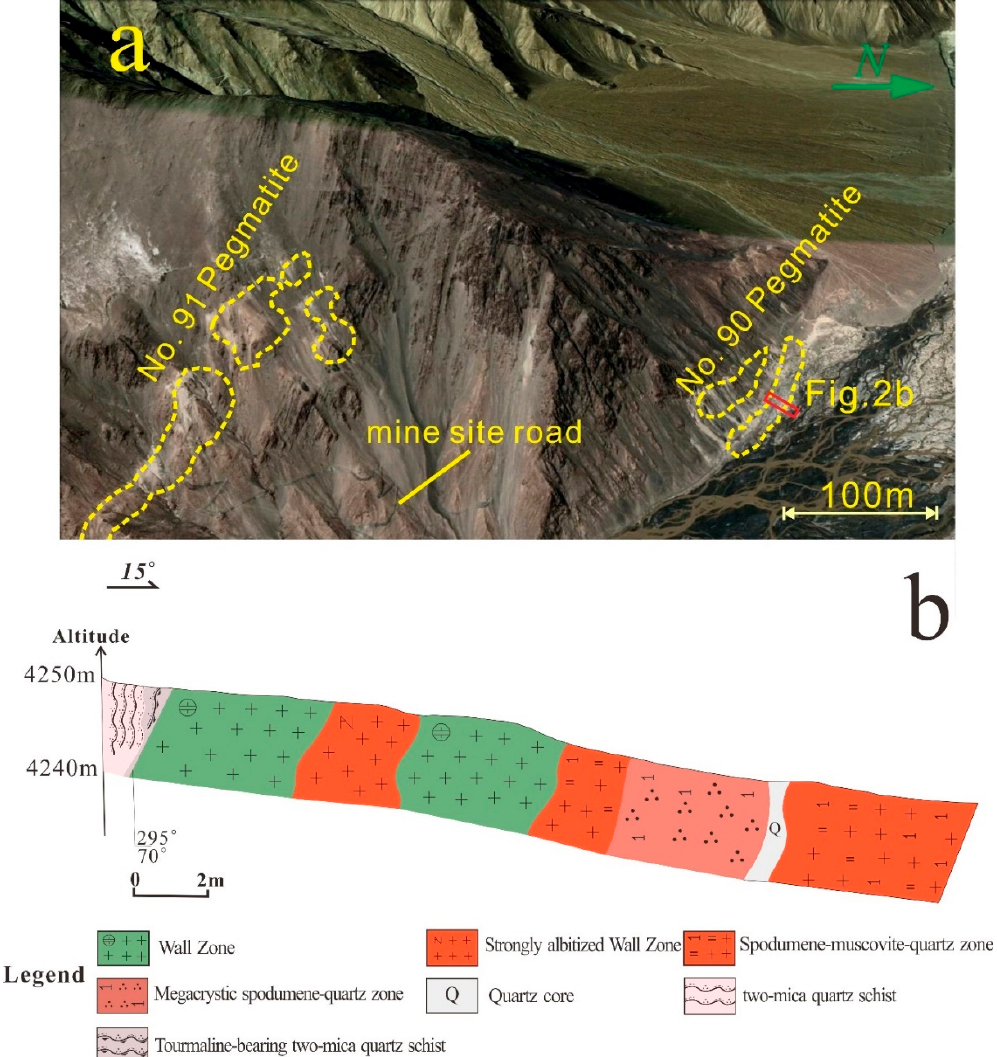
Figure 2. ( a ) Google Earth satellite image showing spatial relationship between No. 90 and No. 91 pegmatites near Dahongliutan (see the area in the blue box on Figure 1b) and ( b ) Cross section of No. 90 pegmatite showing four distinct lithologic zones.